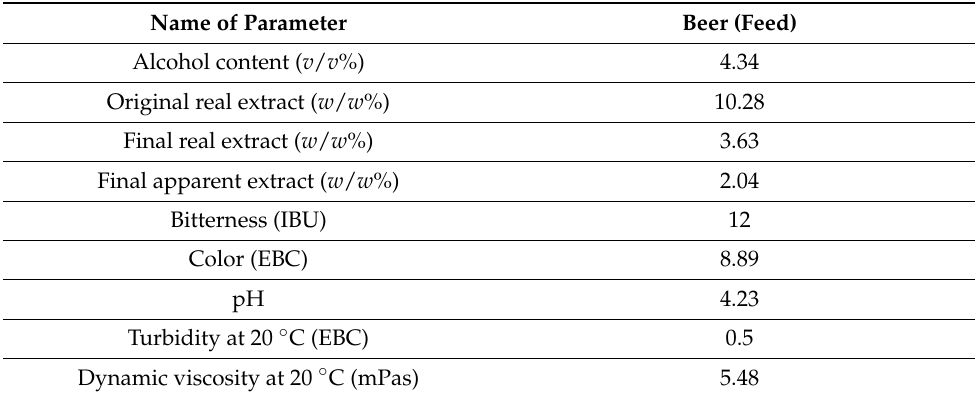
Table 5. Measured analytical parameters of the beer